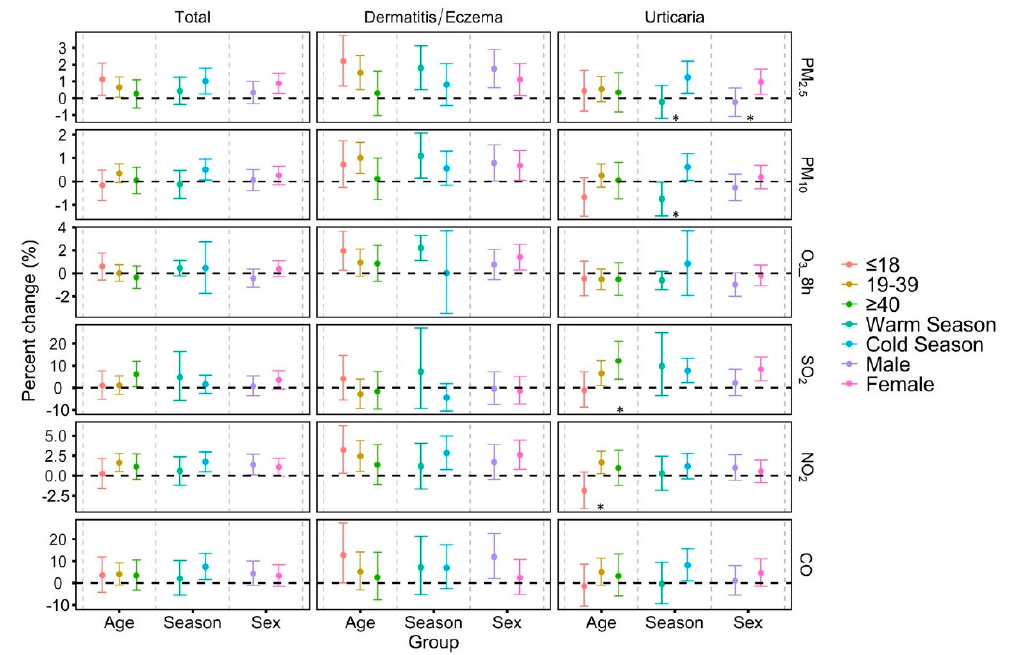
Figure 3. Percent changes and 95% confidence intervals (CIs) in daily emergency room visits for skin diseases per 10 μ g/m 3 increases in PM 2.5 (lag 0–5), PM 10 (lag 0–3), 8 h maximum O 3 (lag 0–5), SO 2 (lag 0–6), NO 2 (lag 0–1) and 1 mg/m 3 increase in CO (lag 0–5) from 2014–2019, stratified by age, season and sex. Note: Warm season: May–Oct; cold season: November–April. * p for subgroup differences < 0.05.